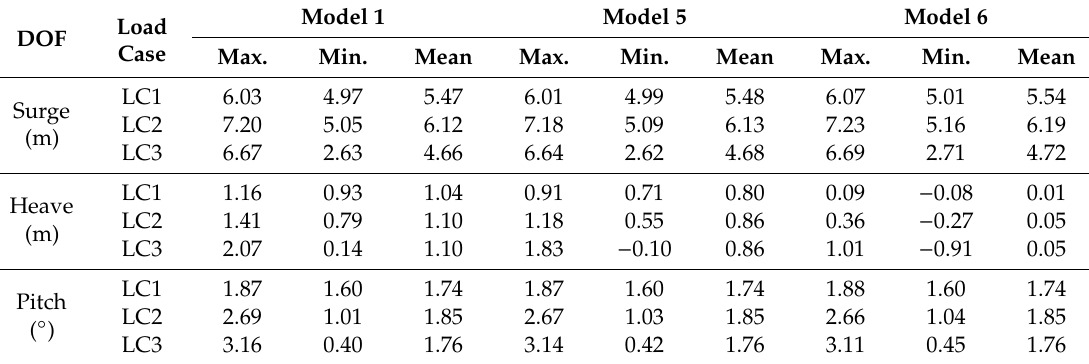
Figure 16. Time domain curves of the pitch motion of the inclined upper column models: ( a ) LC1; ( b ) LC2; and ( c ) LC3. Table 13. Statistics of the stationary motion of the inclined upper column models.